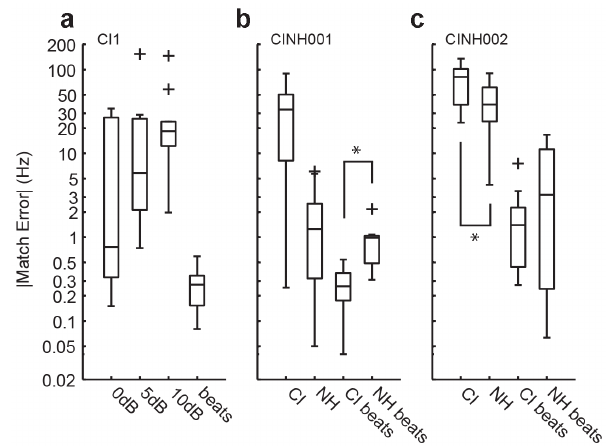
Figure 3. Tuning accuracy. The magnitude of the match error is on the y-axis. The boxplots indicate lower, median, and upper quartile ranges of the data. The whiskers show the full extent of the data. Outliers more than 1.5 s.d. away from are represented by ‘ + ’. ( a ) For CI1, level roving with sequential tone presentation is categorized into 0 , 5 and 10 dB . Data from simultaneous presentation ( beats ) were pooled since there were no significant differences due to level roving. ( b ) Match errors for CINH001 with his implant (CI) and normal hearing ear (NH). The ‘*’ indicates a statistically significant difference (unpaired t-test, p=0.009). ( c ) Match errors for CINH002. Format is the same as b. The ‘*’ indicates a statistically significant difference (unpaired t-test,